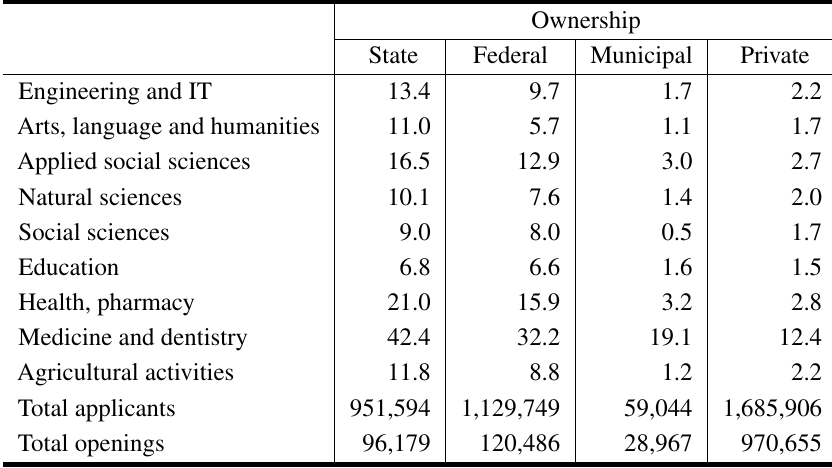
Applicants per place for higher education institutions,